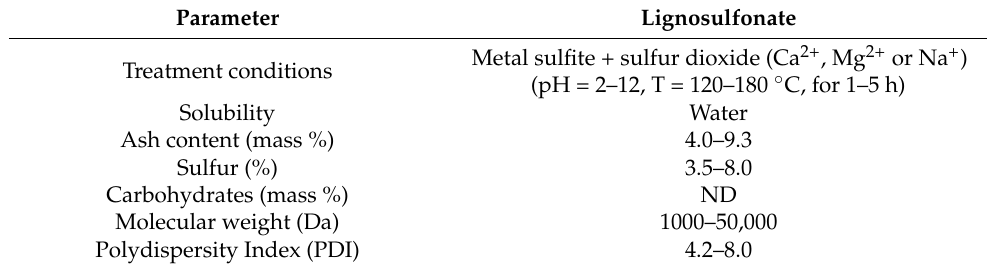
Table 1. Chemical compositions, properties, and treatment conditions of lignosulfonate (LS) adapted from